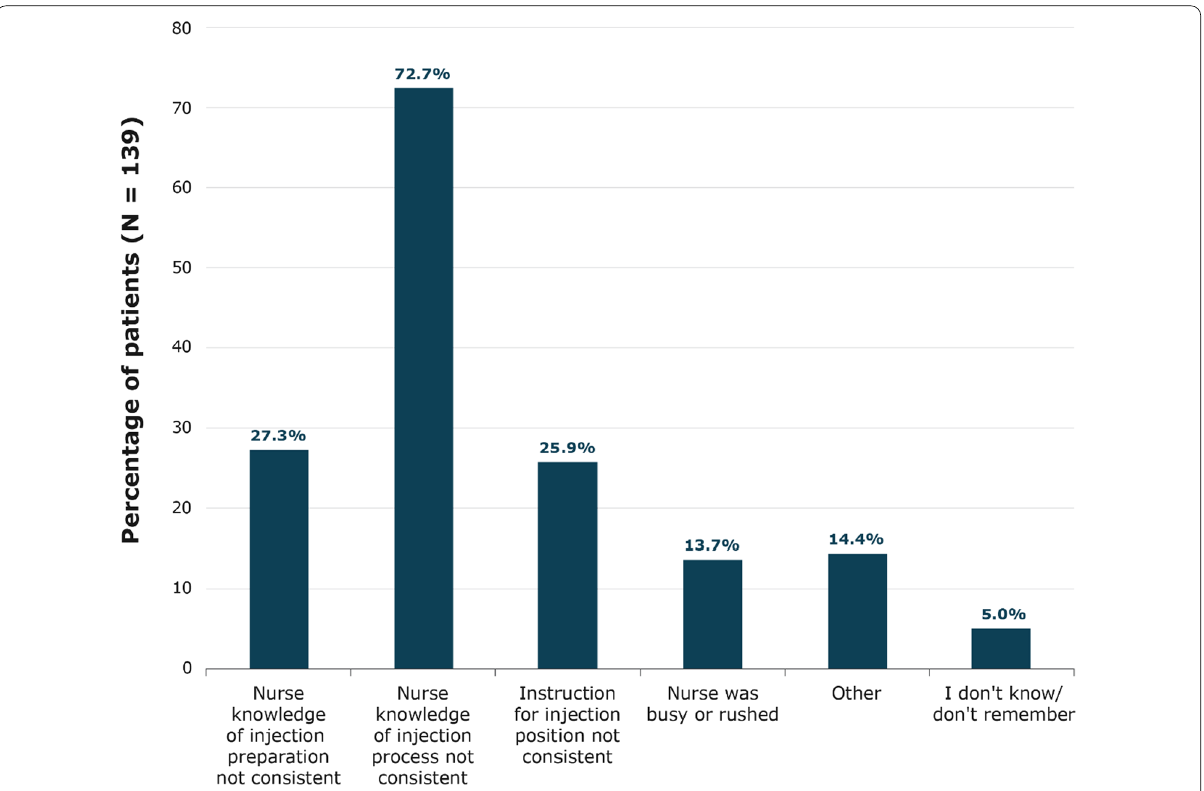
Fig. 3 Patient-Reported Reasons Injection Process Differs by Nursing